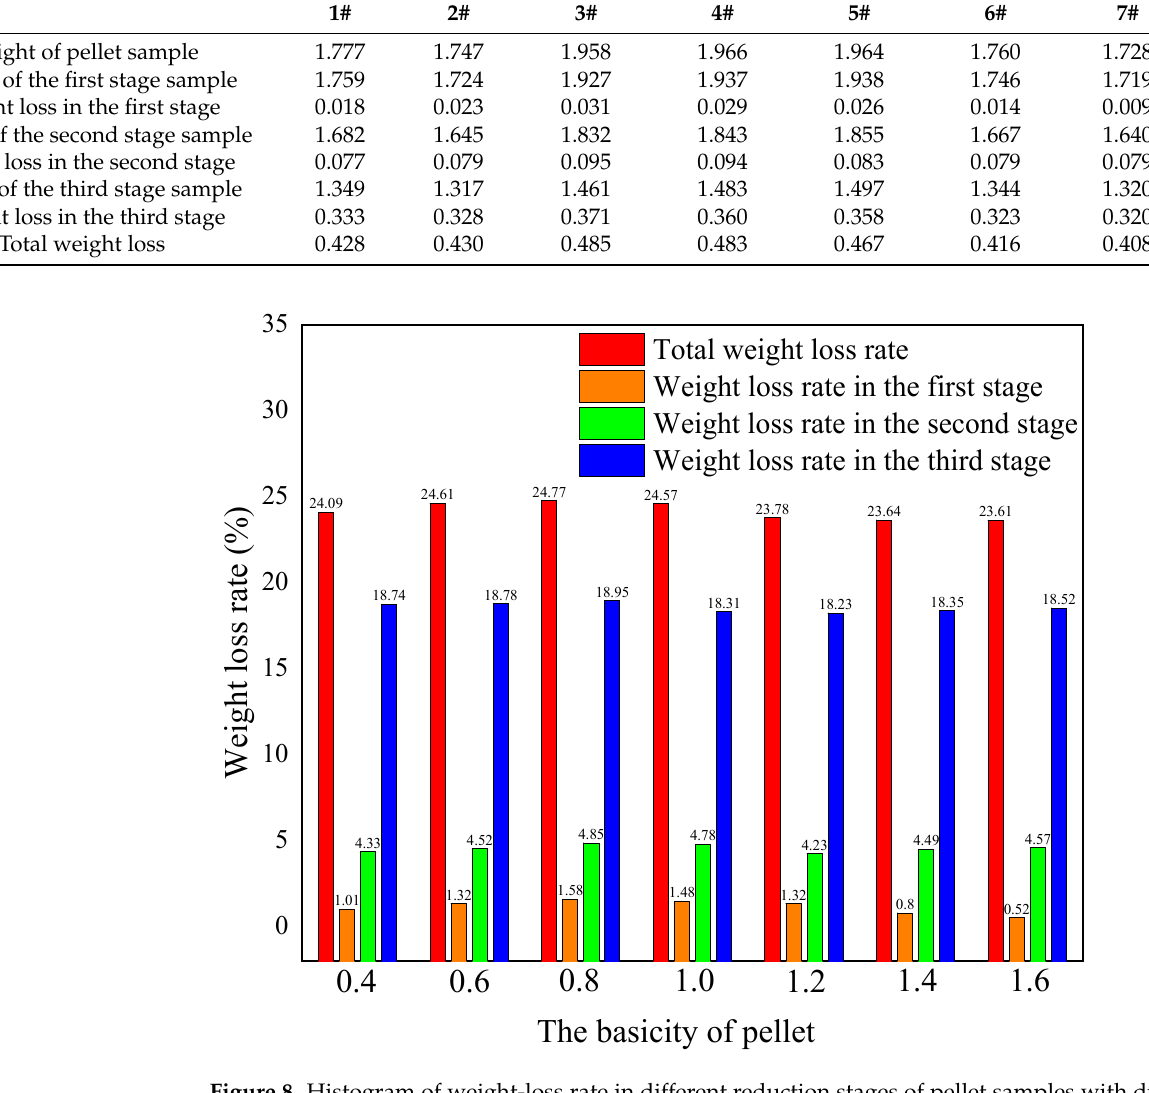
Figure 8. Histogram of weight-loss rate in different reduction stages of pellet samples with differ- ent